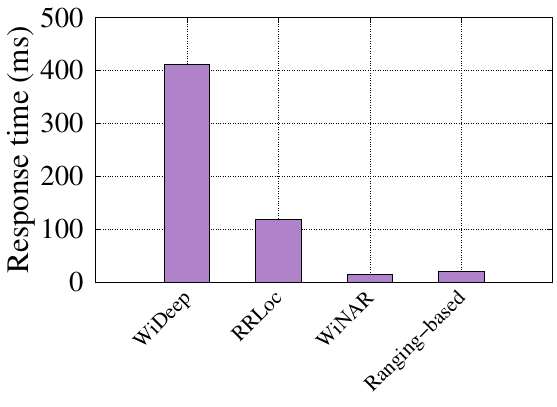
Figure 16. Comparison of run time of the different